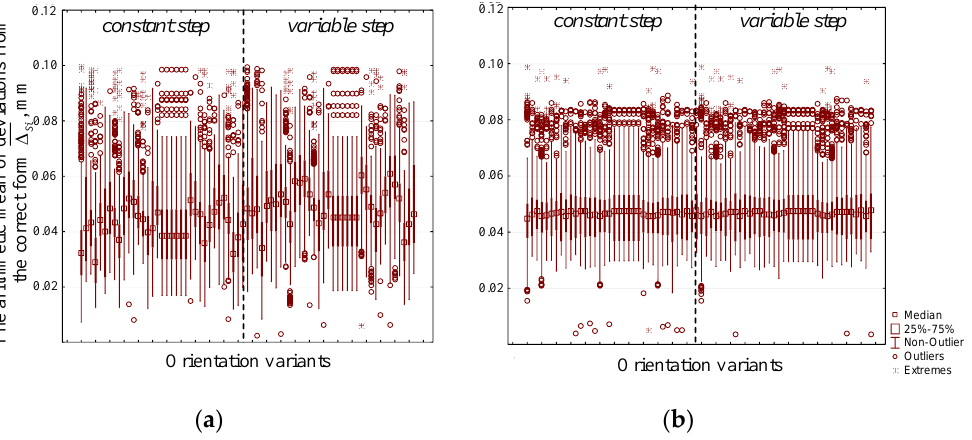
Figure 7. Statistical layered analysis of the arithmetic mean value of deviations from the correct surface of the 3D models: ( a ) Analysis results from the 3rd test 3D model (Figure 2c); ( b ) Analysis results from the 4th test 3D model (Figure 2d).